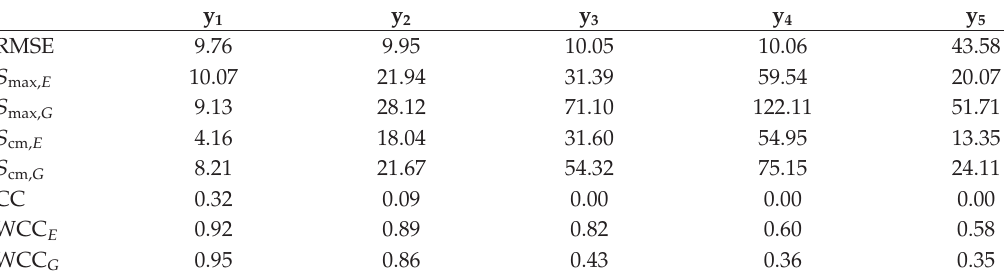
Table 3: Evaluation of reconstructions depicted in Figure